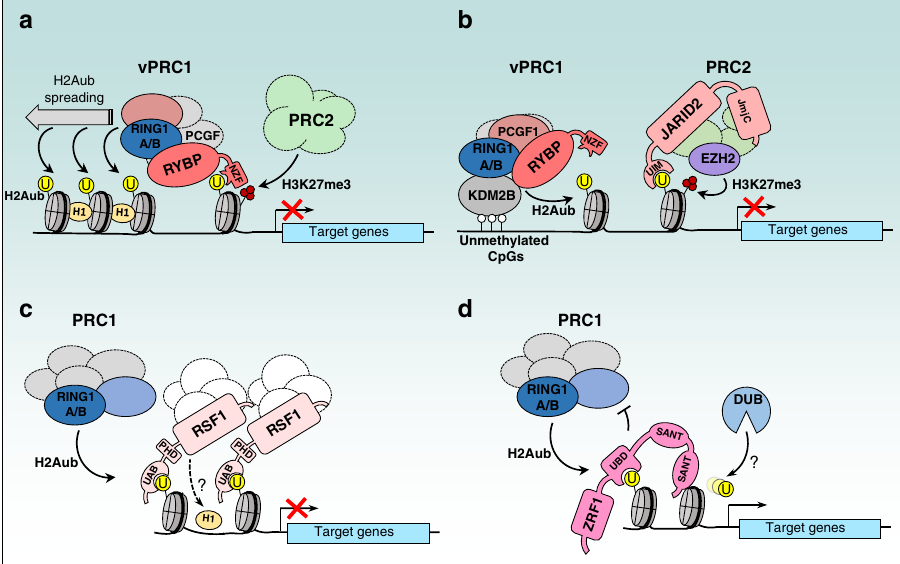
Fig. 4 H2Aub readers in transcription regulation. a The vPRC1 component RYBP uses its NZF-UBD to bind H2Aub. This binding is increased with nucleosome compaction with histone H1 to promote H2Aub spreading and a repressive state of chromatin. b Positive-feedback loop between PRC1 and PRC2 complexes is ensured by the binding of vPRC1 component, KDM2B to unmethylated CpGs island promoting H2Aub deposition. This results in a speci fi c binding of nucleosomal H2Aub by the PRC2 component JARID2 through its UIM domain. JARID2 binding promotes the recruitment of the PRC2 complex and eventually the establishment of H3K27me3 by EZH2 and maintenance of gene repression. c RSF1 binds H2Aub through its UAB domain and promotes the recruitment of the RSF1 chromatin-remodeling complex. This ensures proper nucleosome arrangement at target gene promoters with maintenance of histone H1 positioning, ensuring gene transcription repression in collaboration with PRC1 complexes. d ZRF1 uses its UBD Ubiquitin-Binding Domain to bind H2Aub, thus blocking the access of PRC1 to the nucleosomes, and likely promoting recruitment of DUBs, allowing ubiquitin removal and transcription activation. Ubiquitin is shown as a yellow circle and H3K27me3 is shown by the three red